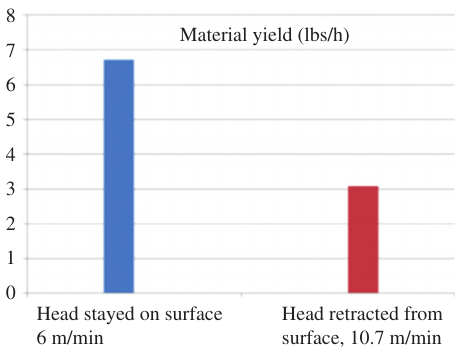
Figure 18 Influence of course division on material yield.